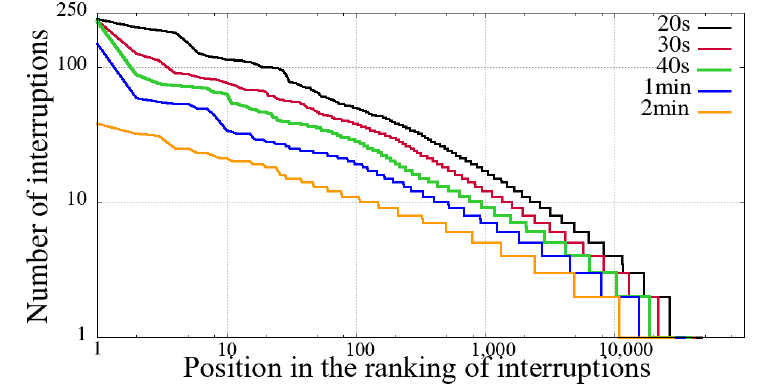
Figure 4. Interruption ranking from users of the Opening Rio 2016 Olympic Games for different sizes of interruption—mobile devices.